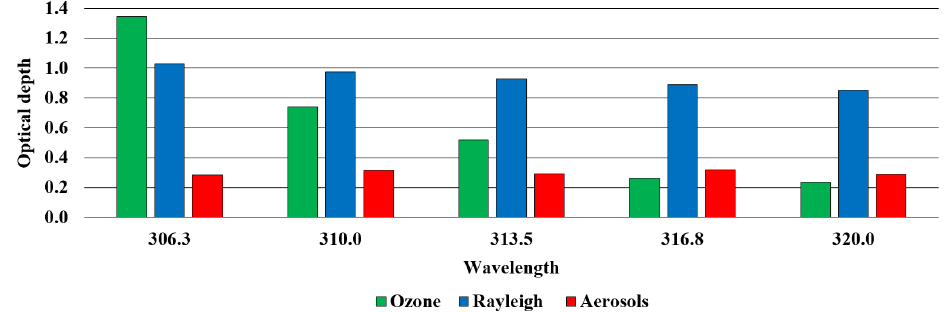
Figure 11. Comparison of long-term averages for the total ozone optical depth, the optical depth of Rayleigh scattering and AOD, 1994–2016.